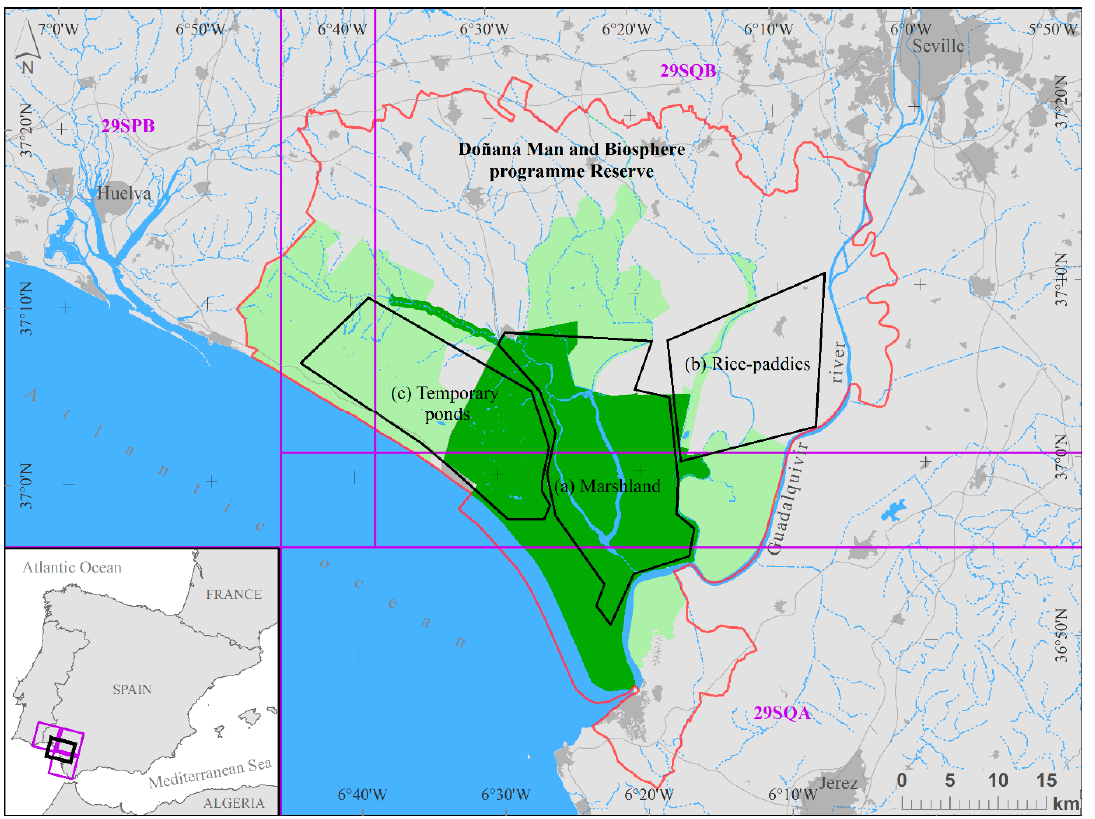
Figure 1. Map of the study area located in southwest Spain. All assessments were carried out for the Biosphere Reserve area as shown in this figure, additionally including a buffer zone of 1 km outside the boundary line. Red line: Biosphere Reserve, which is formed by the natural park in light green and the national park in dark green; purple line: Sentinel-2 tiles. The boundaries of different types of wetlands, ( a ) marshland, ( b ) rice-paddies and ( c ) temporary ponds, in the Biosphere Reserve are indicated with black lines.